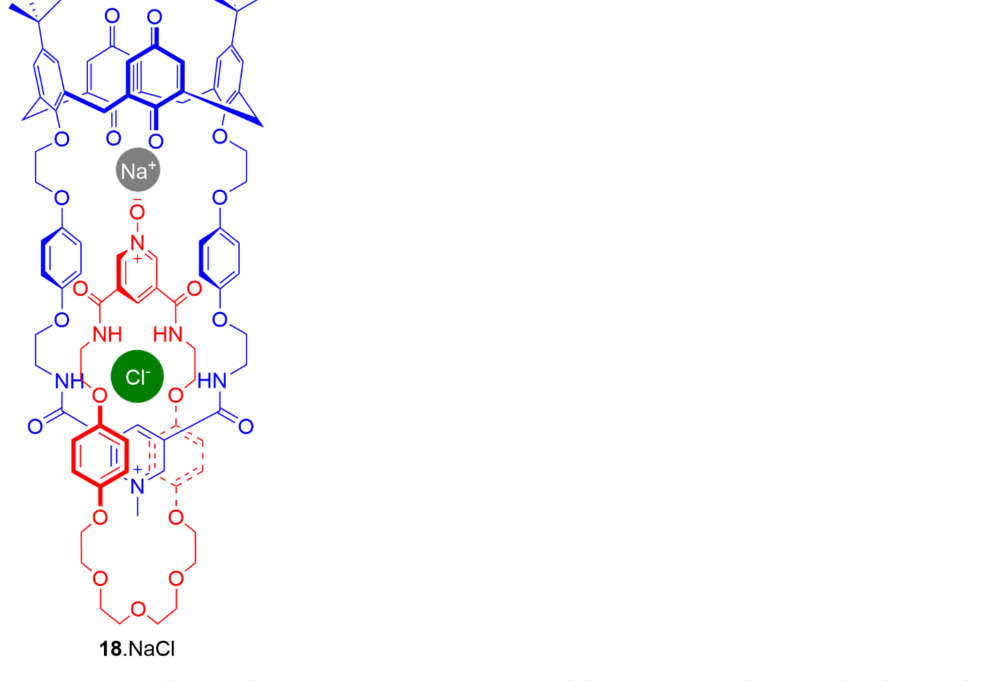
Figure 14. Knighton and Beer’s ion pair catenane 18 exhibiting separated ion pair binding in the solid